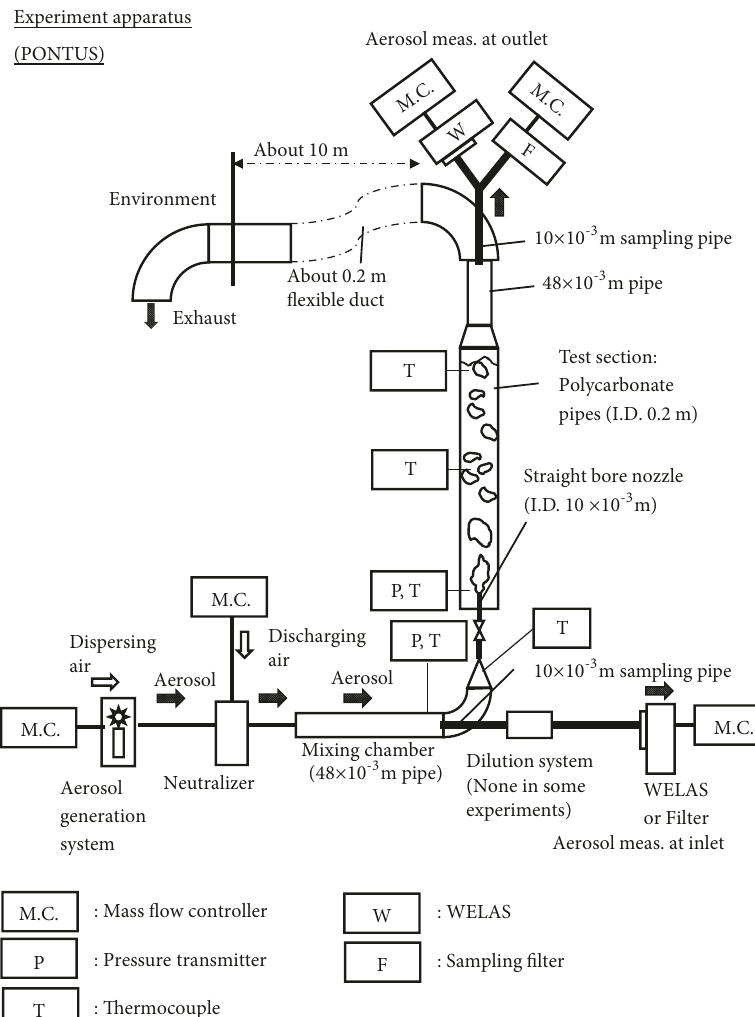
Figure 1: Schematic diagram of experimental